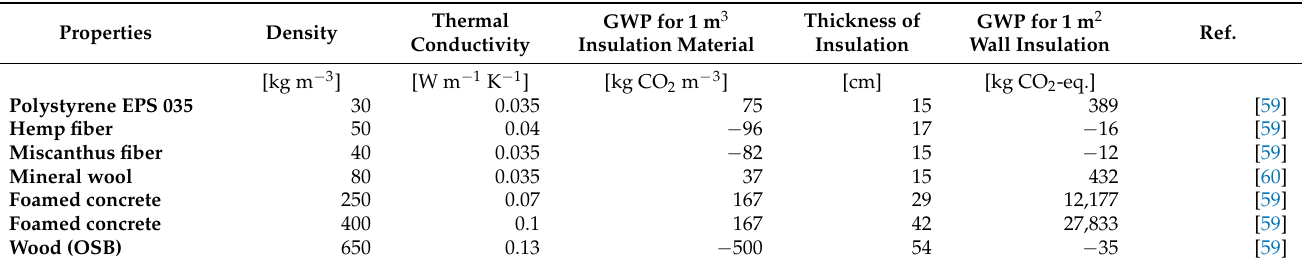
Table 3. Specification of Thermal Conductivity of Popular Insulation Materials and Calculation